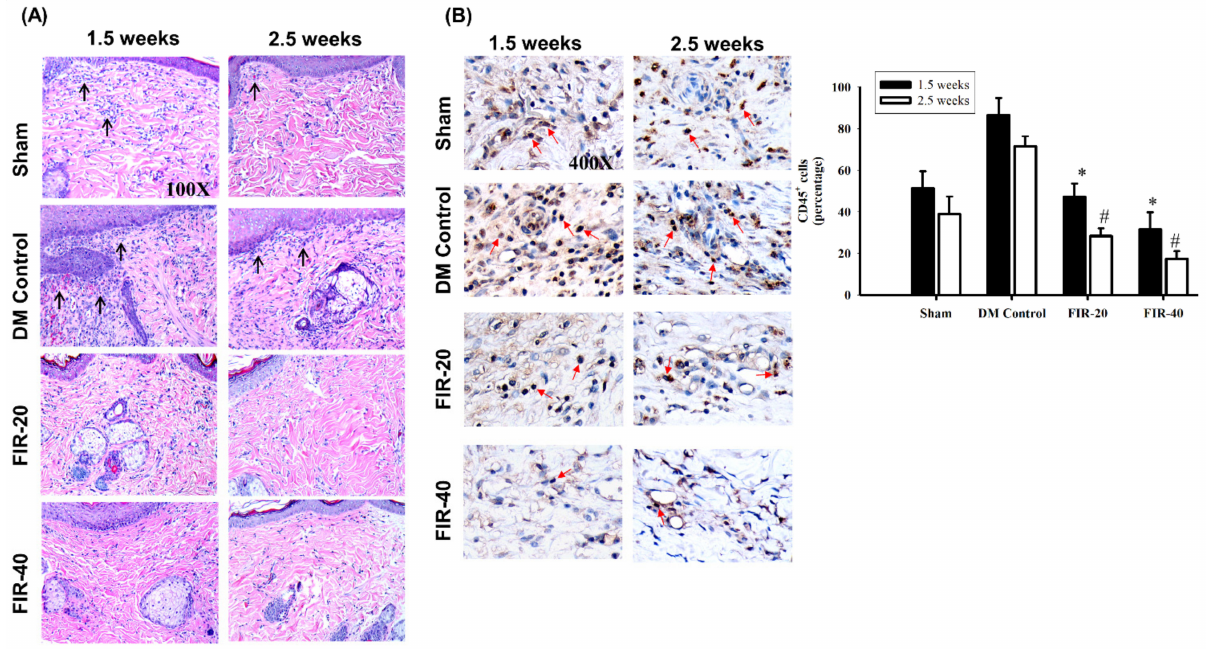
Figure 3. Far-infrared radiation (FIR) treatment suppressed the early inflammatory responses and reduced CD45+ cells in periwound edges. ( A ) The specimens harvested from the periwound area were histologically examined. H&E staining revealed that leukocyte infiltration (black arrows) from the dermis to the subcutaneous muscular layers was markedly reduced in the FIR-20-treated and FIR-40-treated diabetic rat groups at the early phase (1.5 weeks) of post-treatment compared to that in the diabetic controls and consistently decreased at the late phase (2.5 weeks) after treatment among the FIR-treated groups and the diabetic control group without treatments. ( B ) IHC staining indicated that CD45+ expression (red arrows) was significantly decreased in the FIR-20- and FIR-40-treated groups at the early (1.5 weeks) and late-phase (2.5 weeks) after treatment among the FIR-treated groups and the DM control group without treatments. Summary of CD45+ IHC staining in periwound edges after FIR-treatment. Compare with DM, * p < 0.05 (at 1.5 weeks); # p < 0.05 (at 2.5 weeks). Magnification, 100 ×